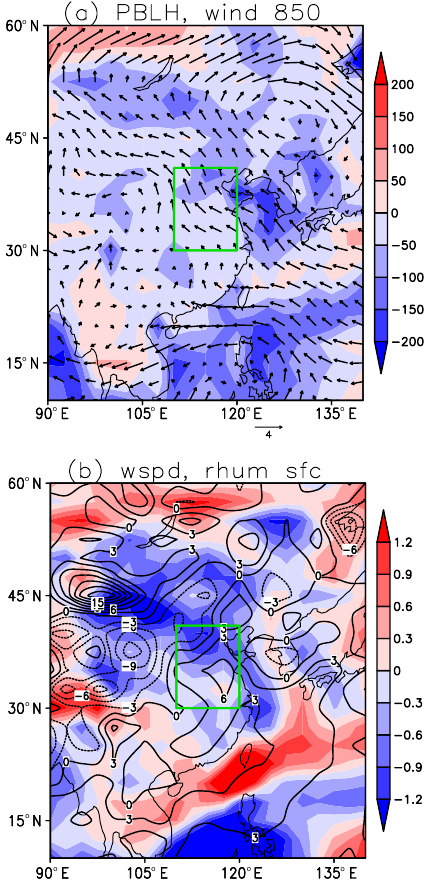
Figure 3. Distribution of the regional atmospheric circulation anomalies, (a) the height of the PBL (shading), and wind at 850hPa (arrow); and (b) surface wind speed (shading) and surface relative humidity (contour) in December 2016. The anomalies here are cal- culated with respect to the period from 1981 to 2010.